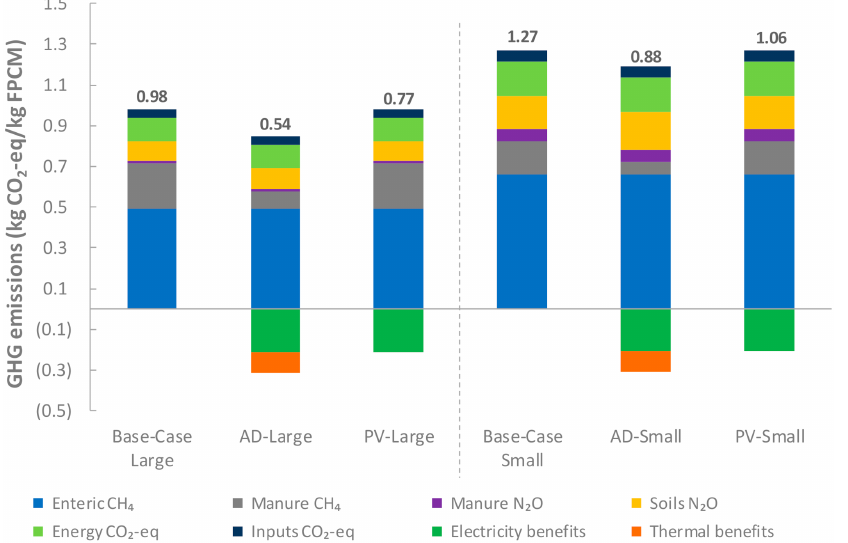
Figure 4. GHG emissions from the base-case large and small dairy farms (no renewable energy production), the same farms with AD systems (including solid-liquid separation), and the same farms with solar PV systems producing the same electricity than the corresponding AD